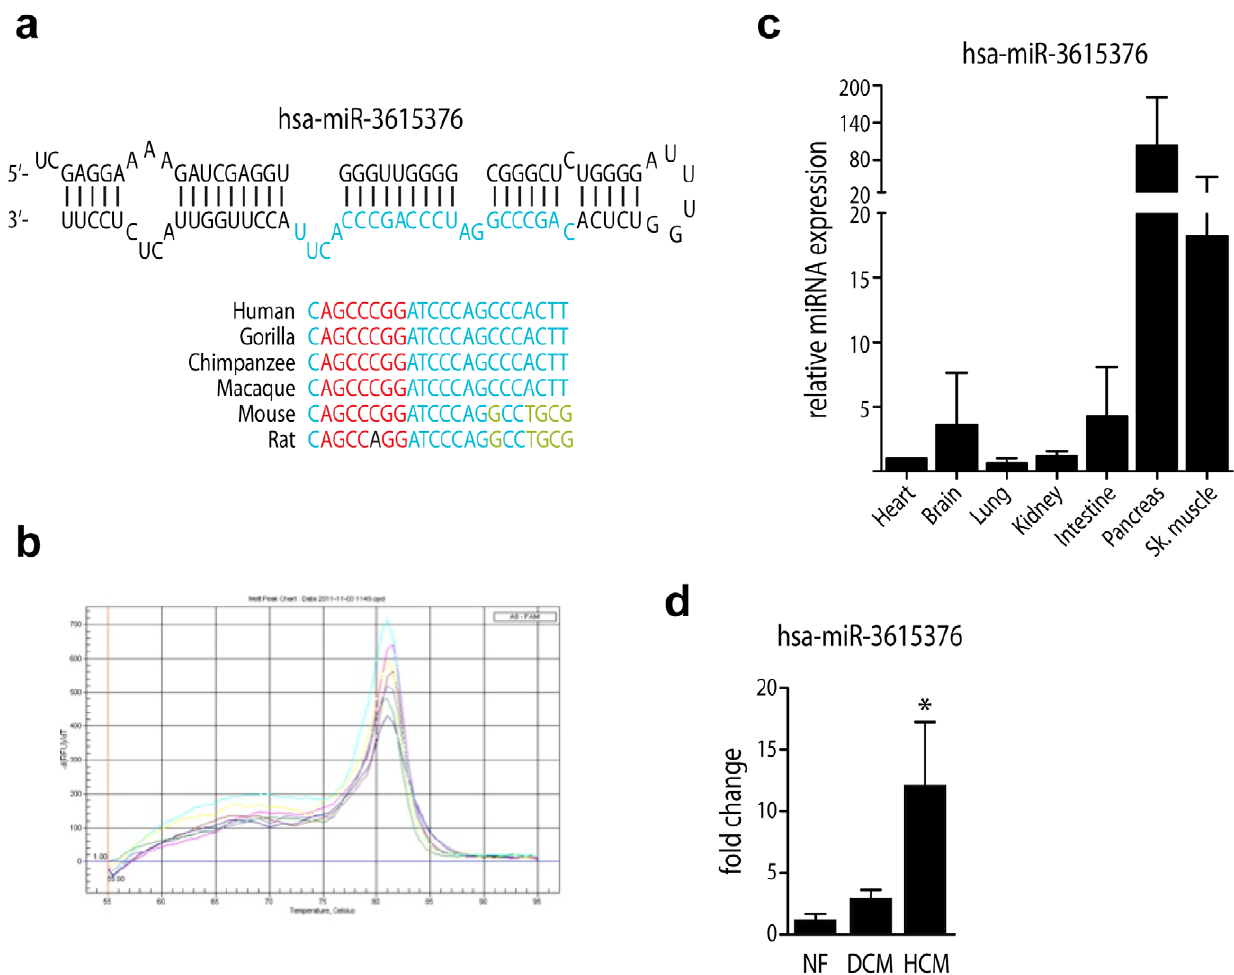
Figure 4. Identification of a novel microRNA. A, Schematic representation of the conservation of a novel microRNA, miR-3615376 among different species. B, C, Real-time quantitative PCR analysis of miR-3615376 expression in different mouse tissues. D , Expression pattern of miR- 3615376 in the DCM and HCM libraries.